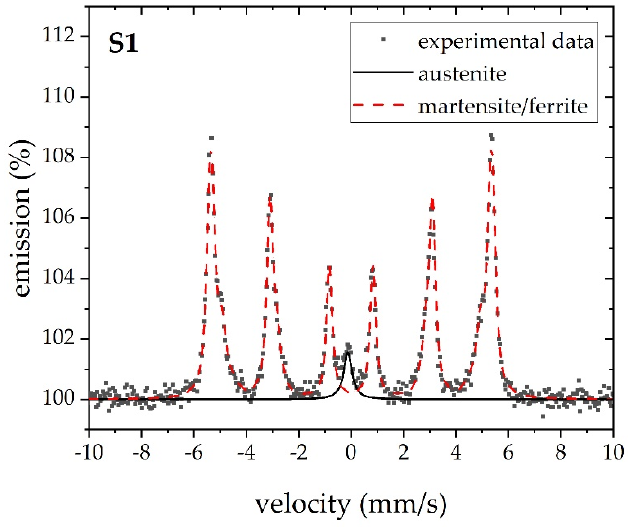
Figure 4. Mössbauer spectrum of sample S1 recorded in the wide velocity interval.